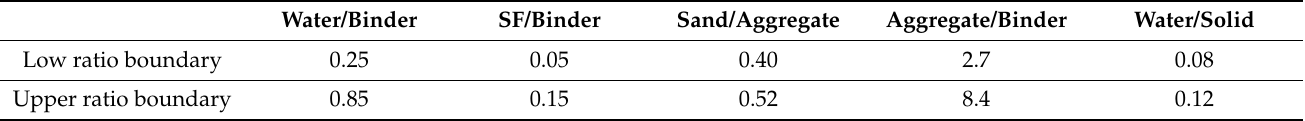
Table 3. Upper and lower ratio boundaries of concrete